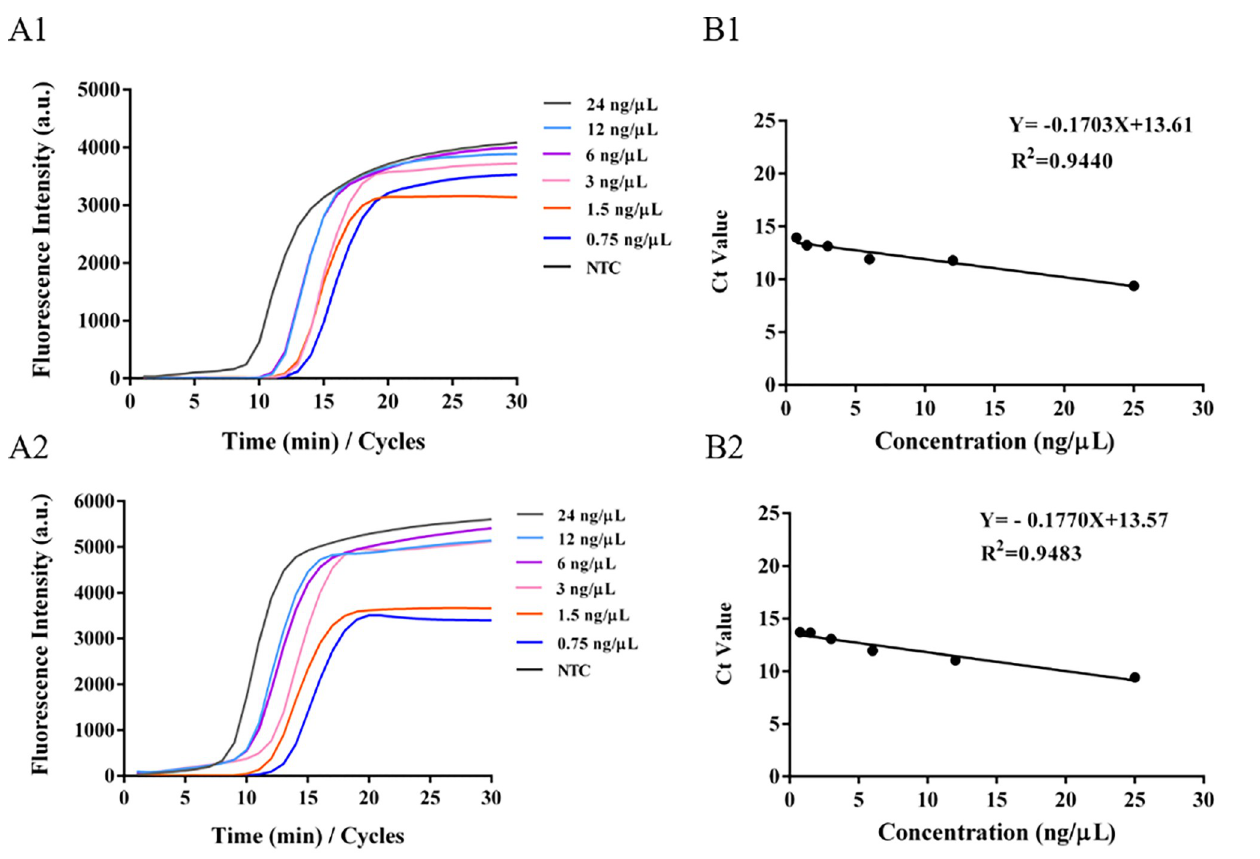
Fig 5. LAMP detection of different concentrations of DNA on paper-based microfluidics. Notes: A1 & A2, amplification curves of peanut and soybean DNA with different concentrations; B1 & B2, linear relationship between peanut and soybean DNA concentrations and Ct value.